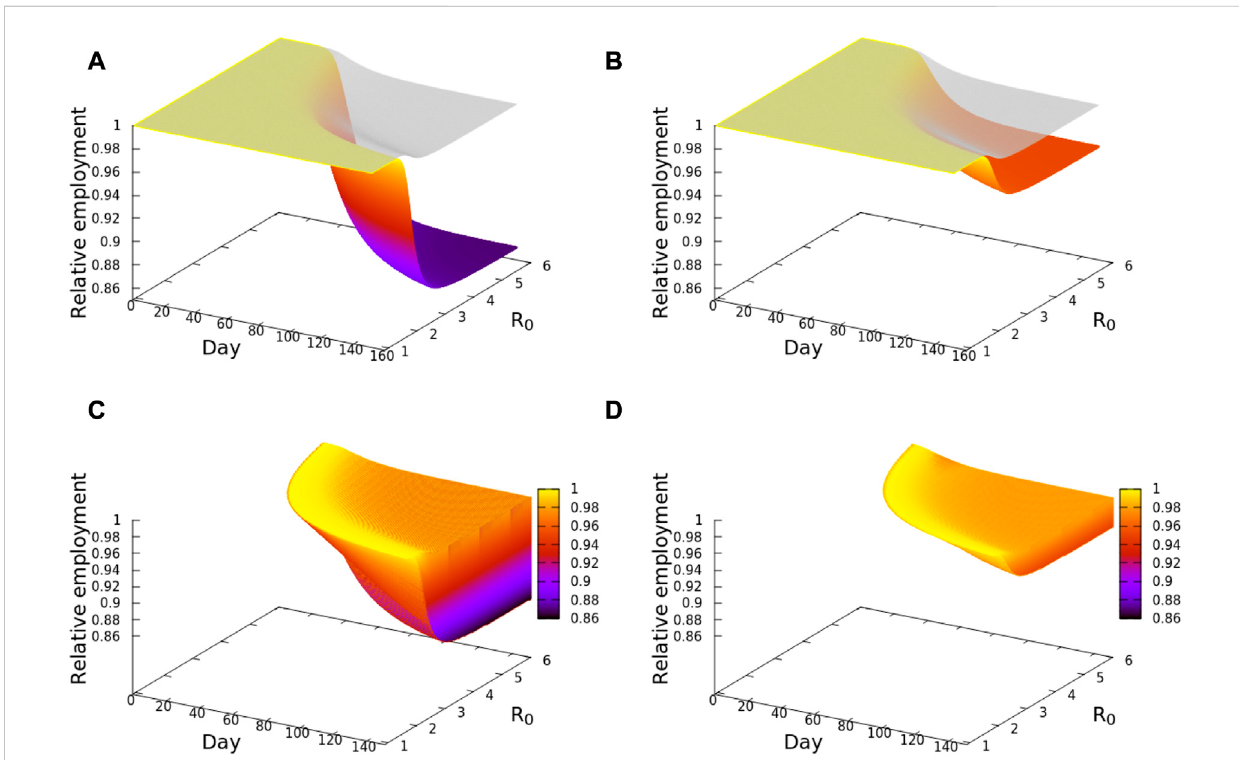
FIGURE 3 (A) Fresno disease-driven (grey) and employment cascades(colored)for R 0 ranging from0.9 to4.0. (B) The LosAngeles-Glendale-Long BeachSES. (C) The wedge represents the Fresno gap between disease-driven and economic cascade reductions of employment illustrated in (A) , visualizing the magnitude of the cascade. (D) Same visualization as in (C) , for the Los Angeles — Glendale — Long Beach